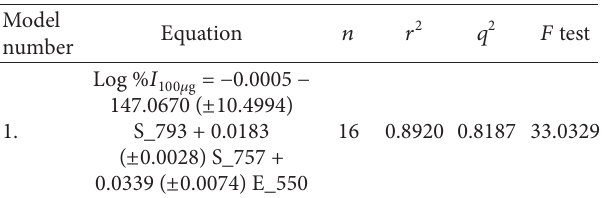
T 3: Selected QSAR model.